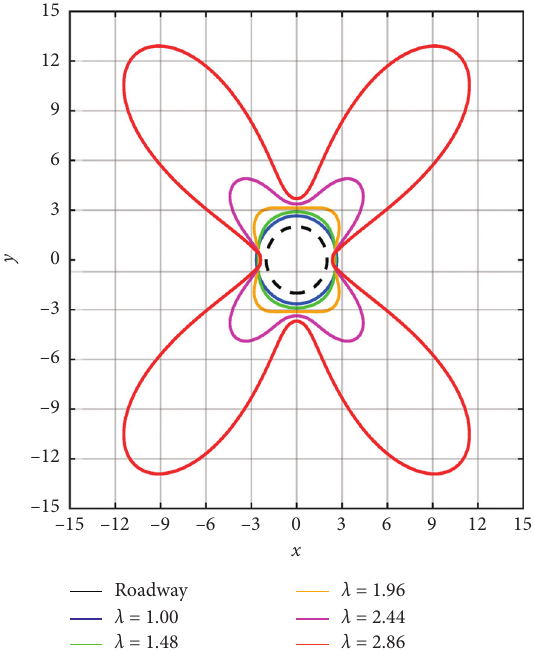
Figure 3: Distribution characteristics of plastic zone for various lateral pressure coefficients.